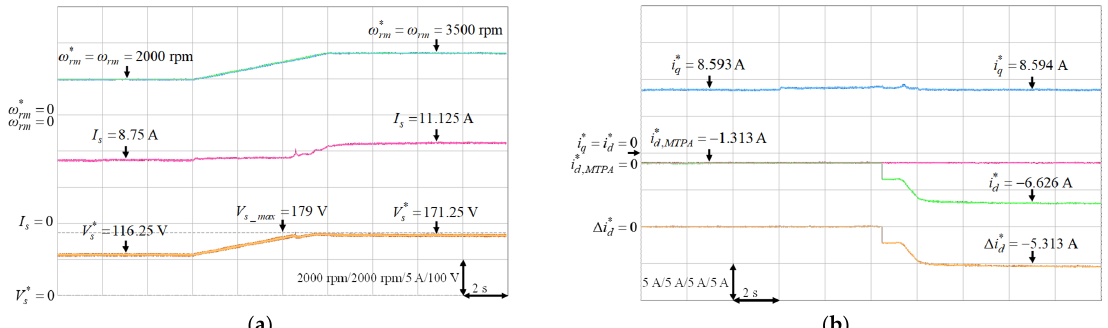
Figure 22. Experimental results of FW control from 2000 rpm to 3500 rpm under 5.43 Nm load torque: ( a ) Mechanical speed command, mechanical speed, stator current and stator voltage command; ( b ) q -axis current command, d -axis current command of MTPA, d -axis current command and variation of d -axis current command.